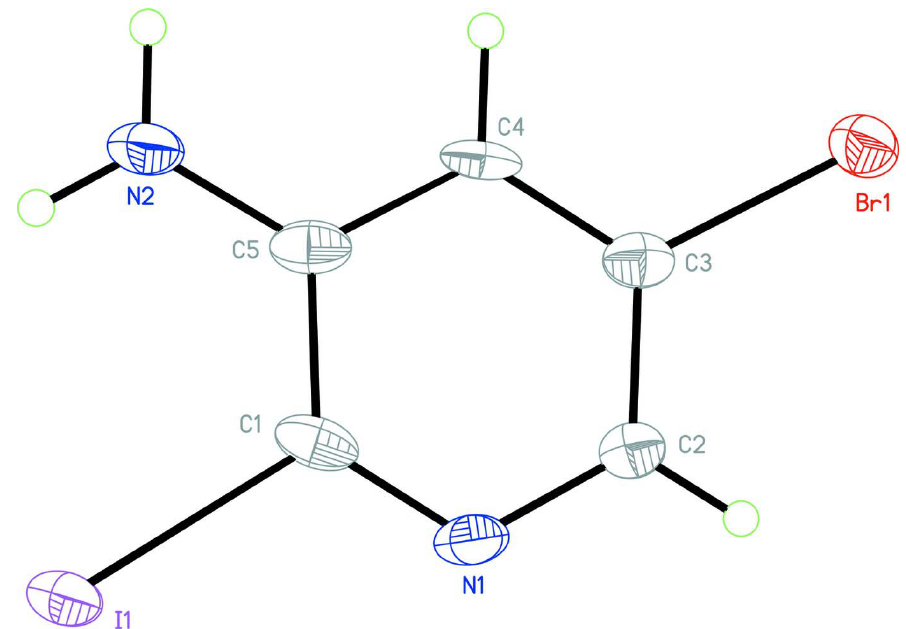
Figure 1 Molecular structure of the title compound, showing 50% probability displacement ellipsoids and atom numbering scheme. H atoms are drawn as circles with arbitrary small radius.